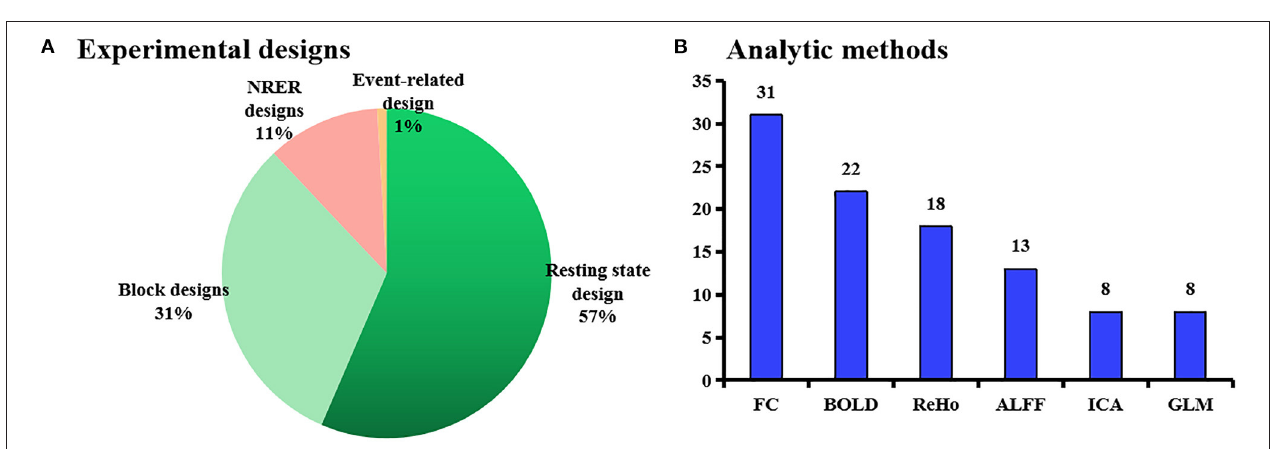
FIGURE 3 | (A) Proportion of the top ten most studied diseases in the reviewed studies. (B) Frequency of the top ten most used acupoints in the reviewed studies. (C) Percentage of meridians where acupoints are located in the reviewed studies. AD, Alzheimer’s disease; BP, Bell’s palsy; BL, the Bladder Meridian; DU, the Du Meridian; HT, the Heart Meridian; KO, Knee osteoarthritis; LI, the Liver Meridian; MCI, mild cognitive impairment; PD, Parkinson’s disease; PC, the Pericardium Meridian; KI, the Kidney Meridian; RN, the Ren Meridian, RN; SJ, the Sanjiao Meridian; SP, the Spleen Meridian.